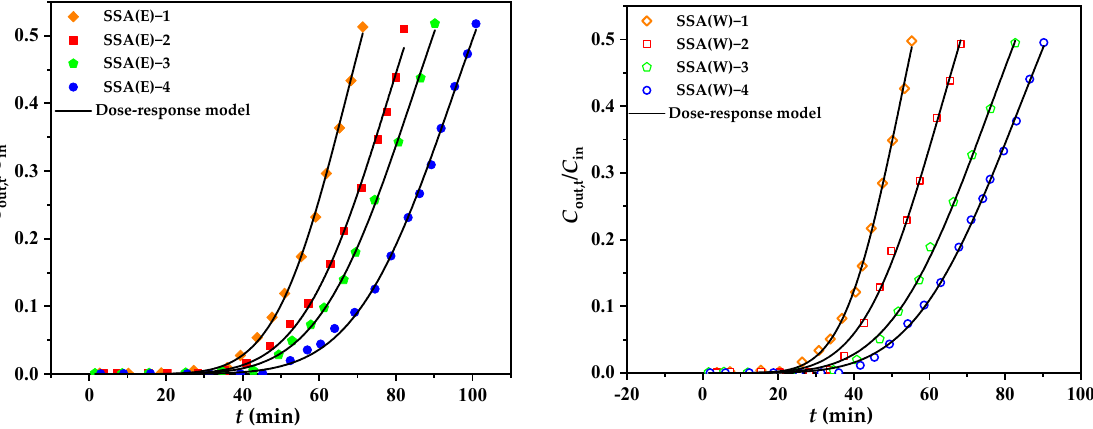
Figure 6. Experimental dotted plots and dose-response model fitting breakthrough curves of SSA(E) and SSA(W) with different H 2 SO 4 loading amounts. Table 3. Experimental and fitting results at different H 2 SO 4 loading amounts.